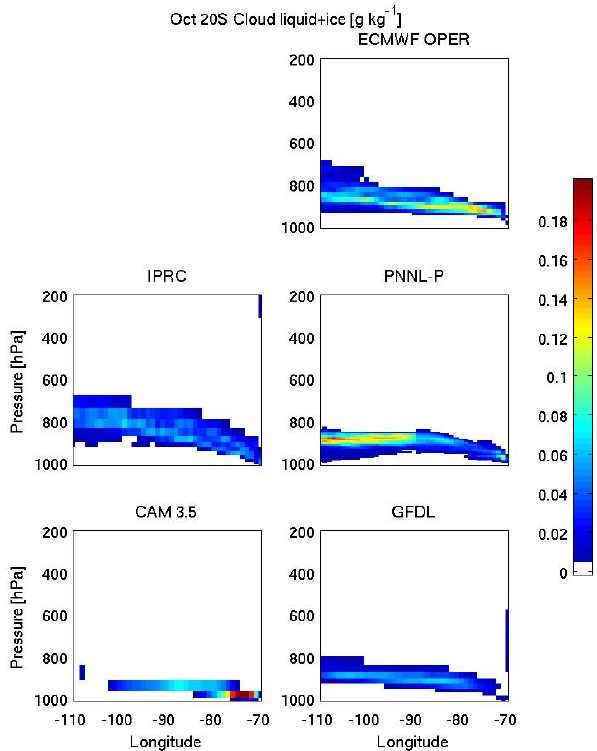
Fig. 9. October 2006 mean 20 ◦ S cross sections of model liquid water content (gkg − 1